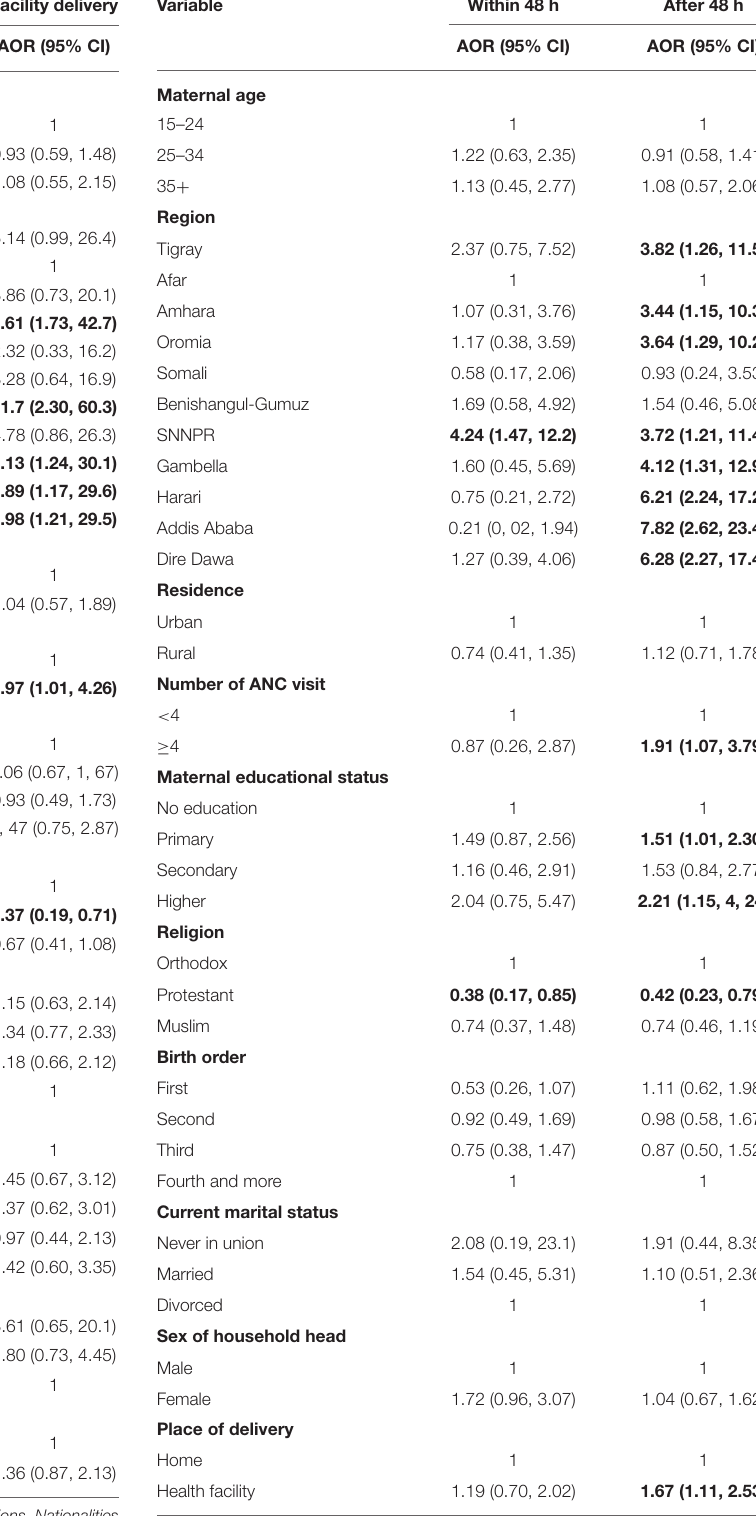
TABLE 3 | Factors associated with timing of the first postnatal checkups among newborns in Ethiopia, 2019.